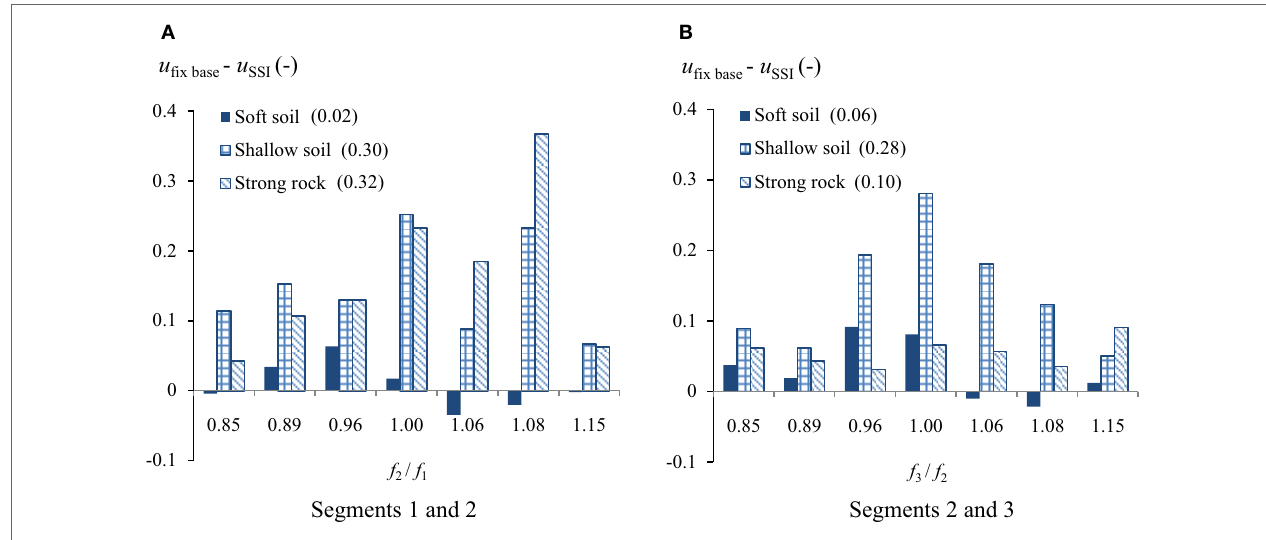
FigUre 10 | Differences between the normalized relative displacements between (a) segments 1 and 2 and (B) segments 2 and 3 with fixed-base foundation and with ssi due to spatially varying excitations .